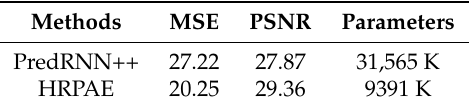
Table 1. Results with the Bouncing Balls